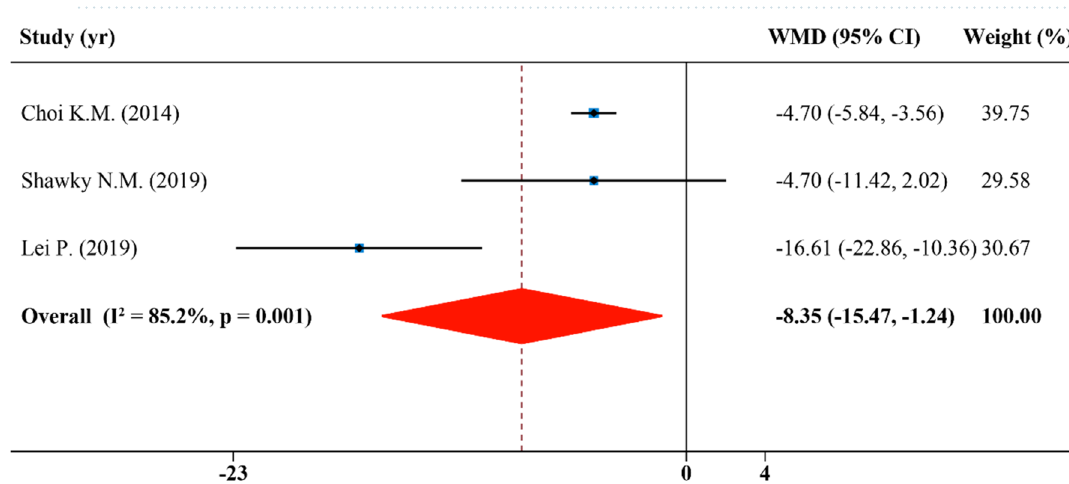
Figure 5. Forest plot showing effects of SFN on serum low-density lipoprotein